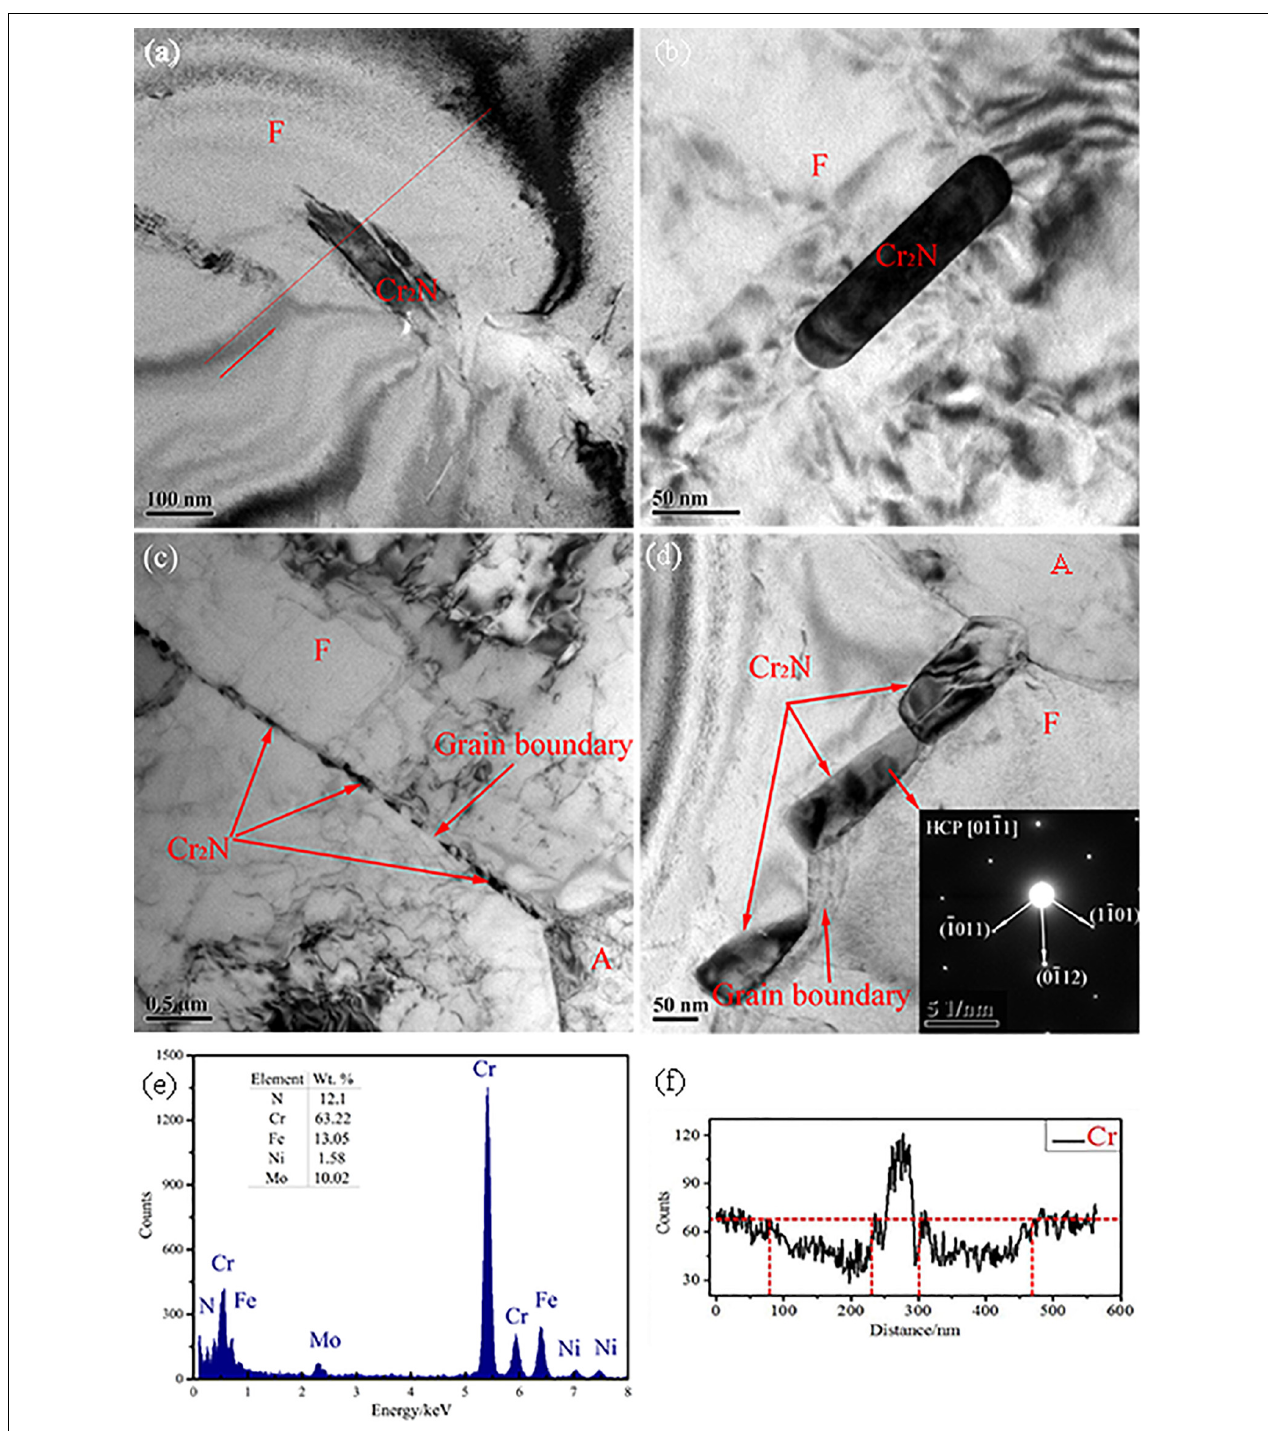
FIGURE 5 | The Cr 2 N observed by TEM: (a) the weld cap; (b) the weld root; (c) the HAZ; (d) the HAZ in high magnification; (e) the chemical of the precipitate in panel (a) tested by EDX; (f) the line analysis of Cr content adjacent to Cr 2 N.